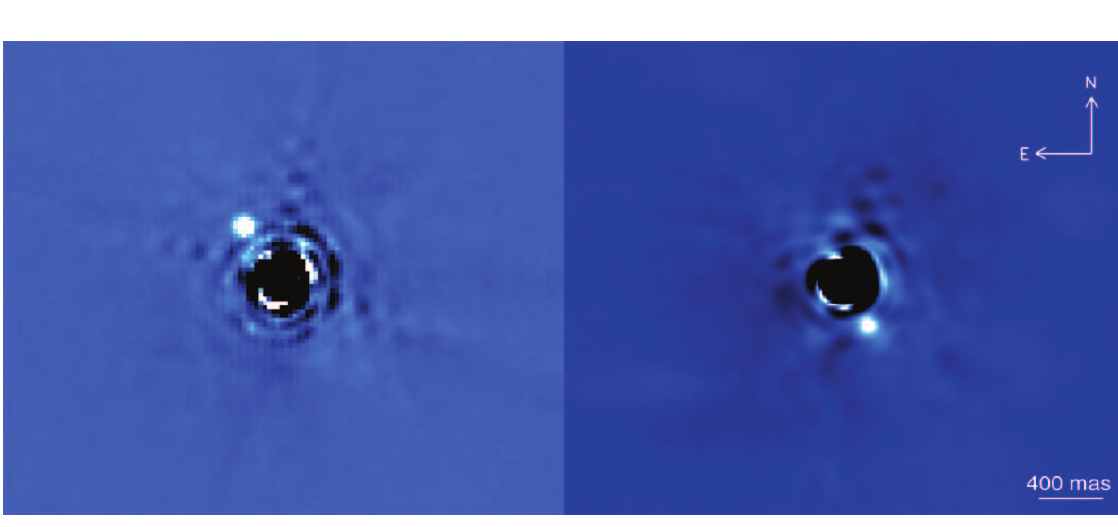
Figure 4. Infrared images of (cid:12) Pictoris taken in November, 2003, and again in late 2009, showing a companion at (cid:24) 10 AU, that has clearly moved substantially between 2003 and 2009. These observations suggest that the object has a mass of about nine Jupiter masses. (Figure from